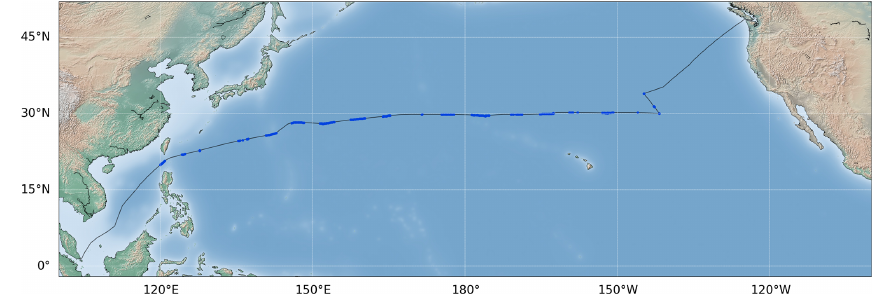
Figure 1. Track of the R/V Sonne (gray line) during the MORE-2 campaign starting from Vancouver, Canada, on 30 May 2019 and entering port in Singapore on 5 July 2019. The blue dots are the locations of all quality-assured EM27/SUN measurements. The map is provided by Wessel et al.